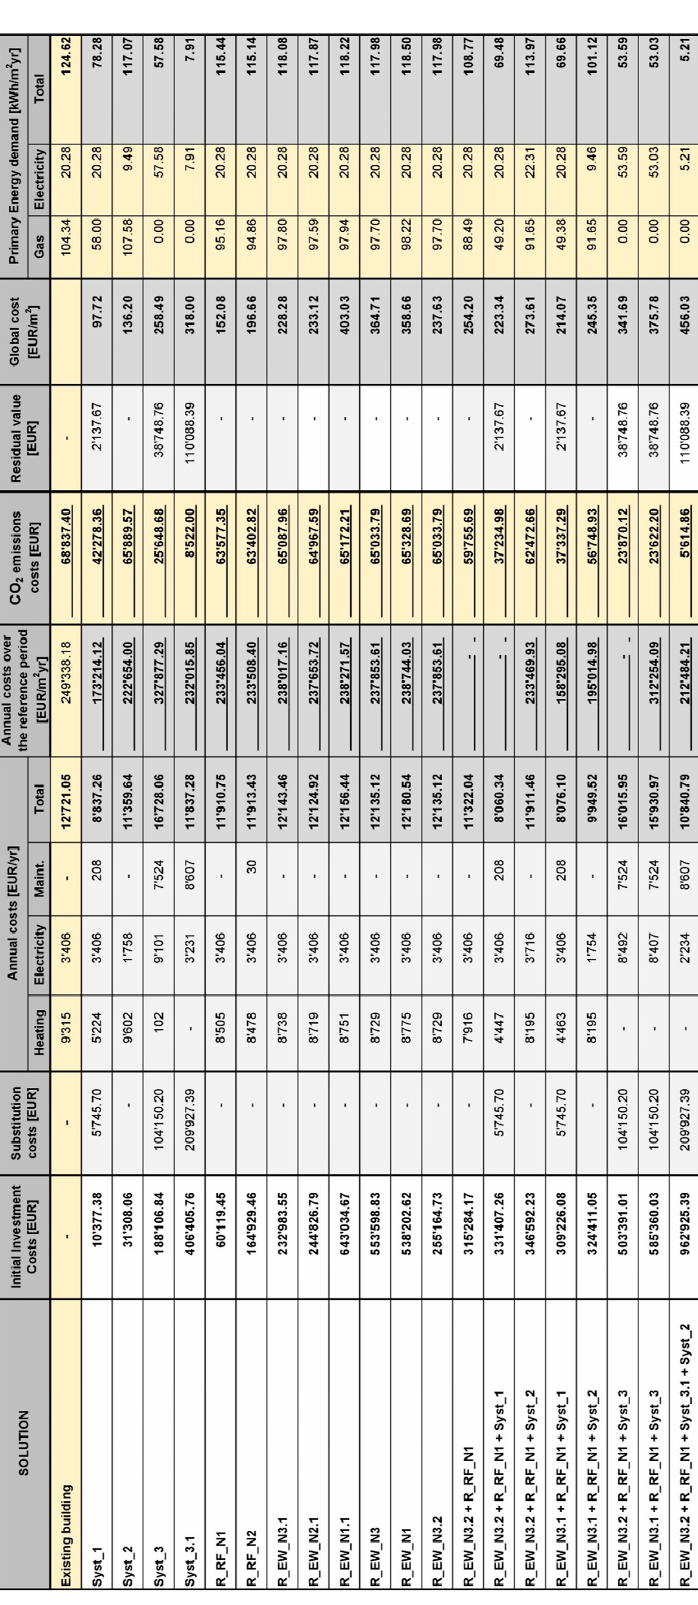
Figure A7. Summary table of cost-optimal methodology for macroeconomic scenario with discount rate equal to 3% for Rodari school.